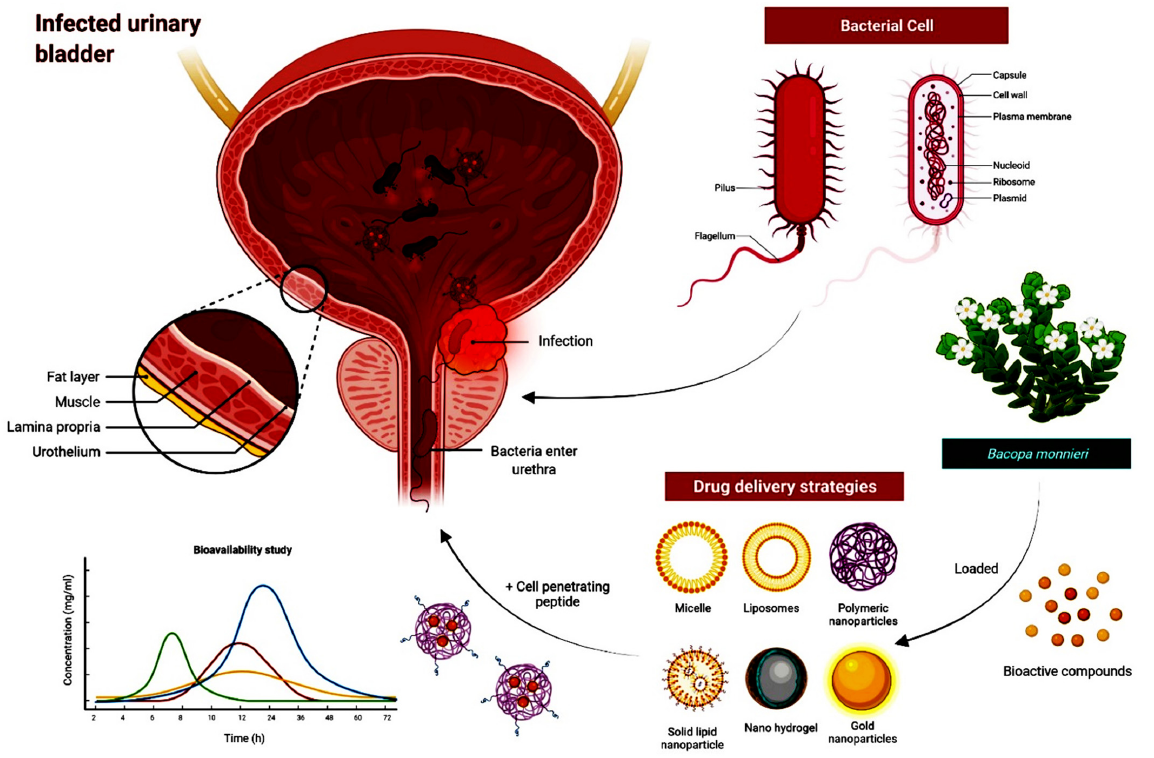
Figure 8. Schematic illustration of the future application of B. monnieri loaded inside polymeric nanoparticles enhanced with a cell penetrating peptide for improving internalization and bacterial eradication in infected bladders. The application of nanotechnology may assist in addressing toxicity concerns, while extending the half-life of bioactive compounds for effective antibacterial